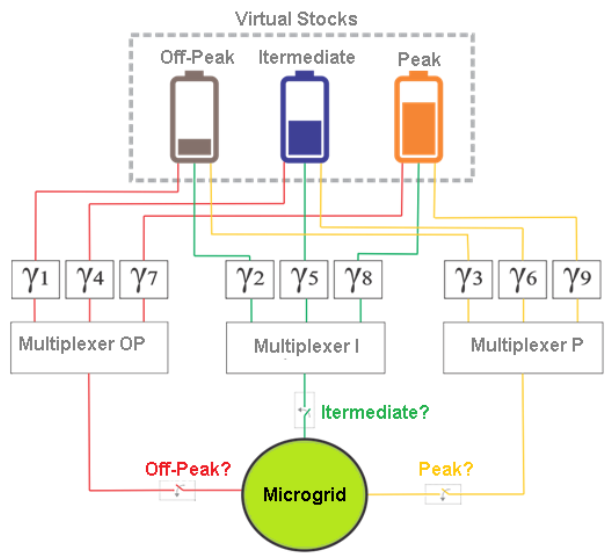
Figure 4. Virtual stocks scheme.